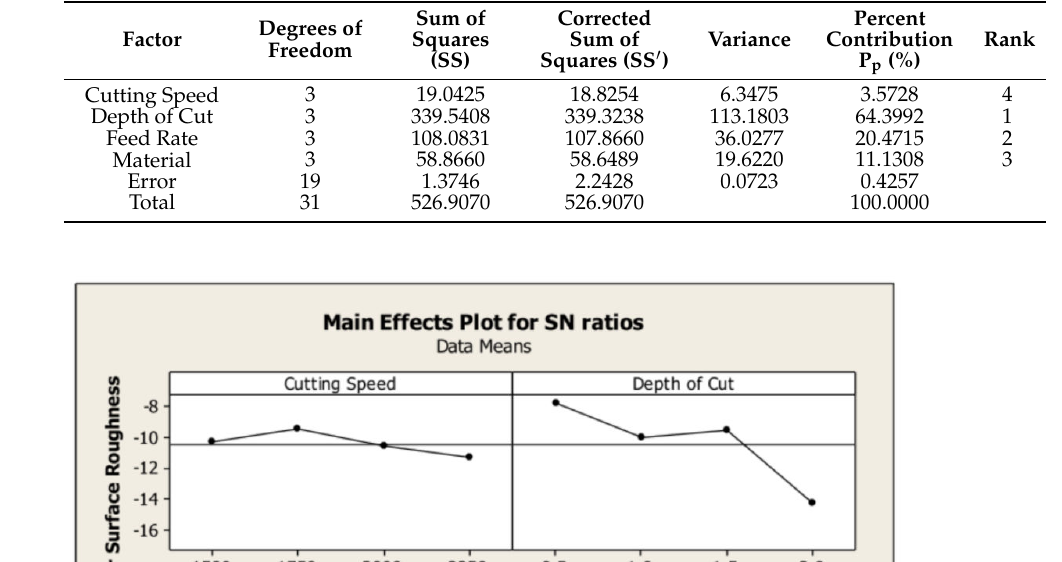
Table 1. Analysis of variance (ANOVA) for the cutting force [50].